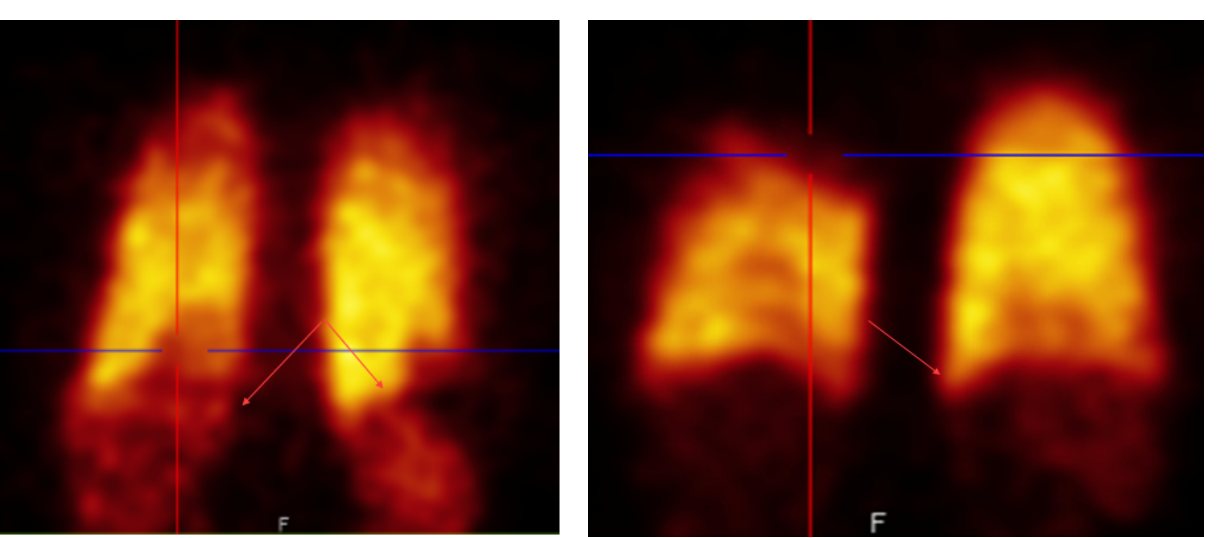
Figure 1. Two examples of abnormal hepatic and spleen uptake seen in lung perfusion scintigraphy